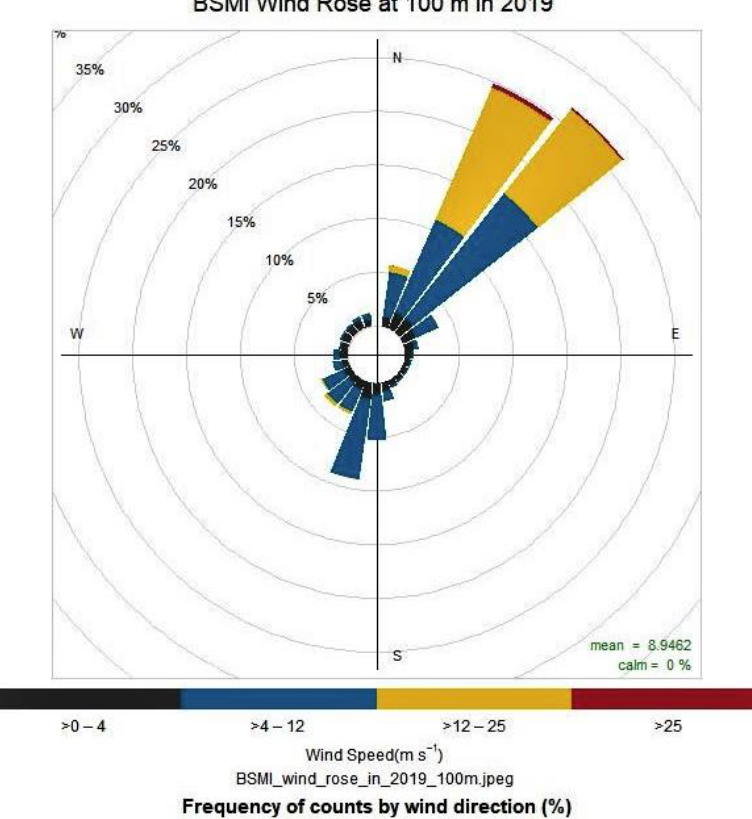
Figure 2. Wind rose at 100m of BSMI met mast in 2019 [48].